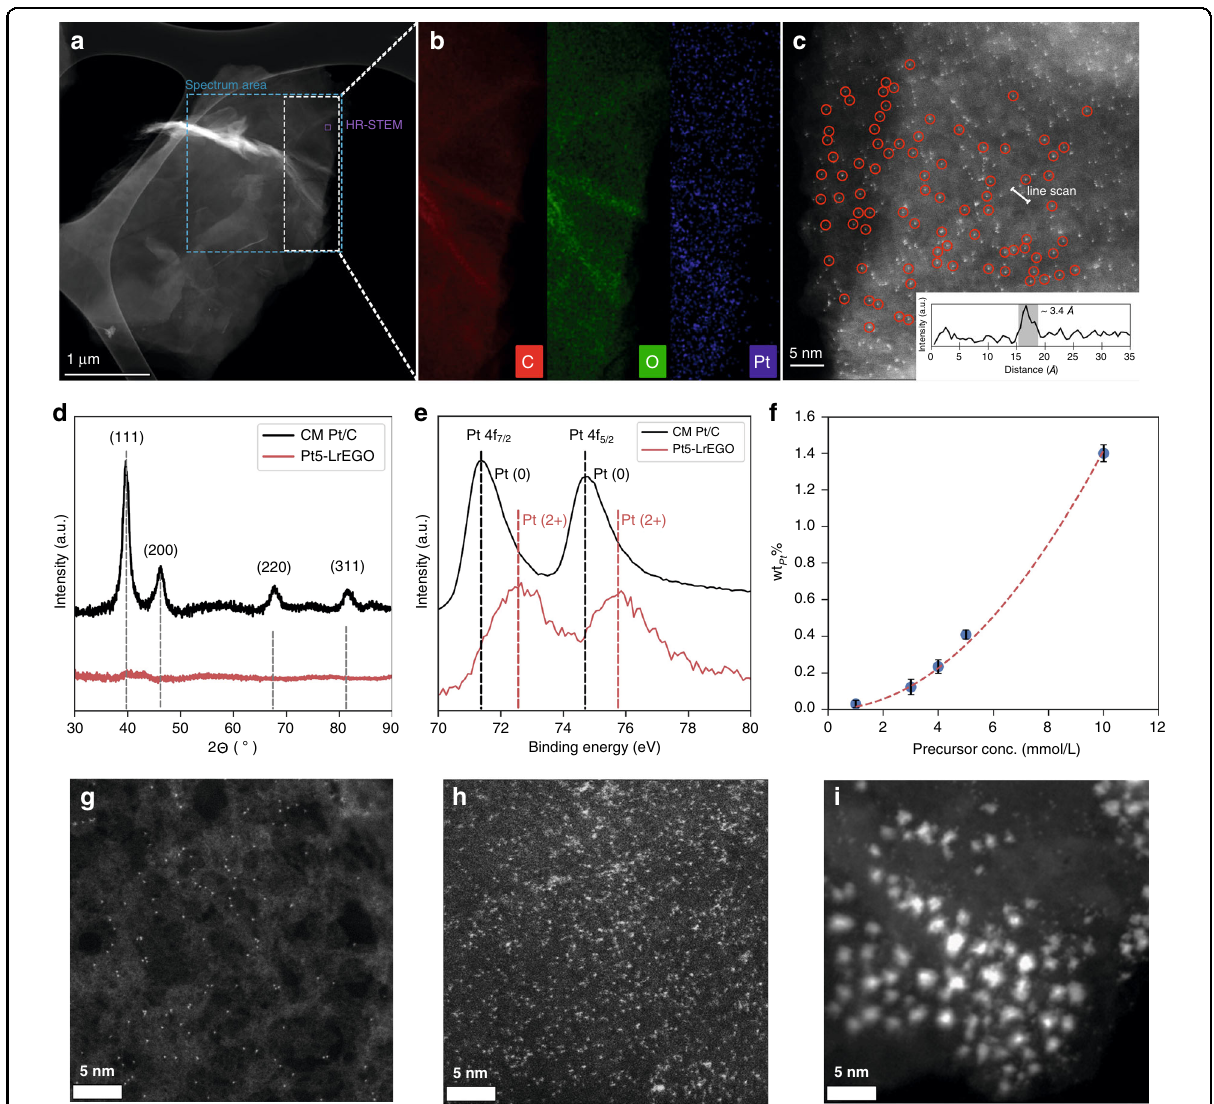
Fig. 2 Structural characterizations of the Pt-LrEGO samples. a HAADF-STEM image of Pt-LrEGO after 1064-nm laser irradiation at a laser fl uence of 7.66 mJ cm -2 and b EDX mapping of C, O, and Pt of the selected area. c Representative HAADF-STEM image showing isolated Pt atoms deposited on LrEGO support (inset shows the representative HAADF intensity pro fi le). d XRD pattern and e XPS spectra of the commercial Pt and Pt5-LrEGO fabricated by 1064 nm laser at 7.66 mJ cm − 2 . f ICP-OES result of Pt loading within Pt-LrGO with various precursor concentrations, and representative STEM images of g Pt1-LrGO, h Pt5-LrGO, and i Pt10-LrGO processed at 7.66 mJ cm −